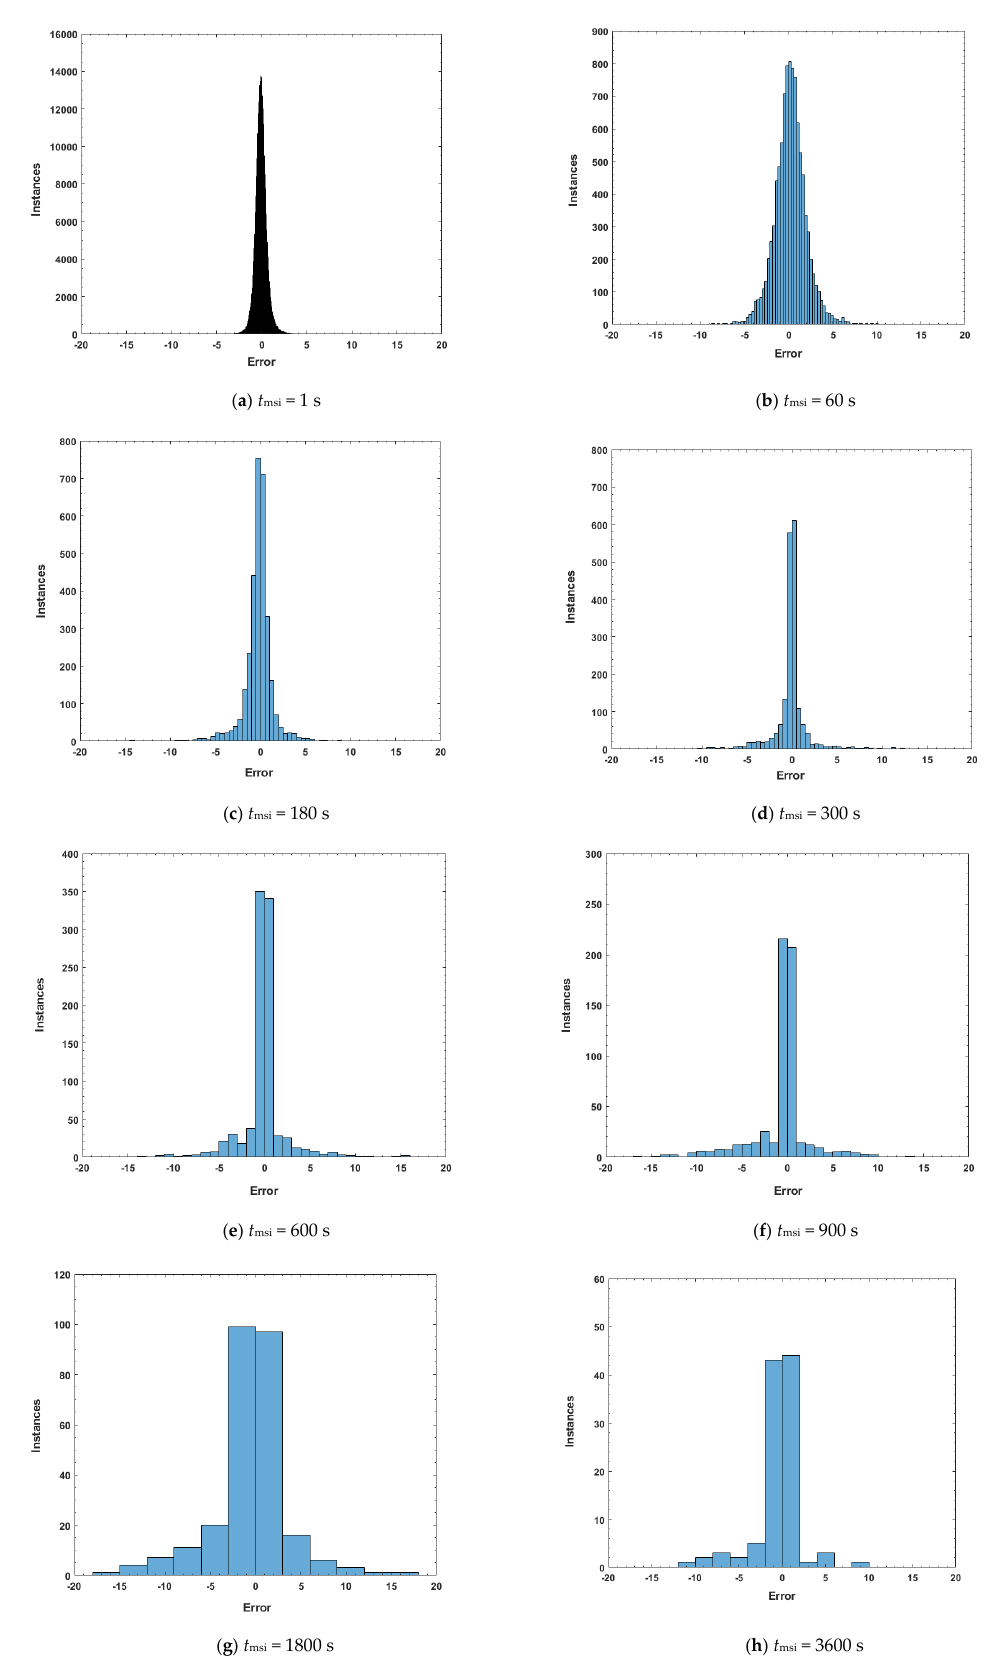
Figure 6. Error histogram for all data using LSTM model.